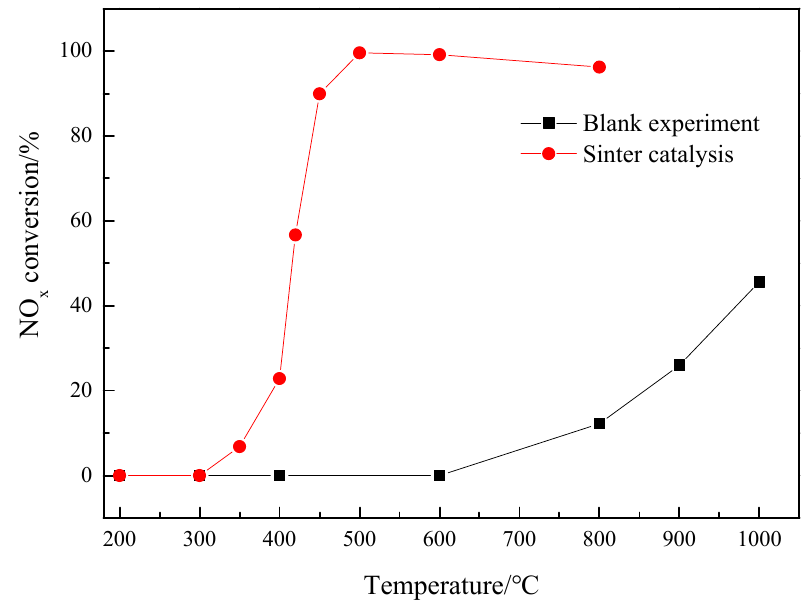
Figure 4. Effect of temperature on catalytic reduction of NO in sinter ores.